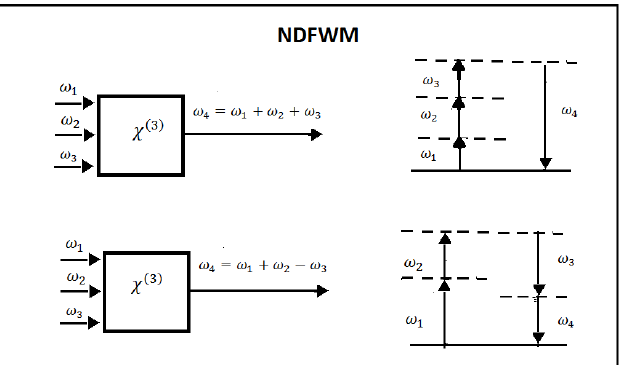
Figure 3. Non-degenerate four-wave mixing. Two of the possible mixing process that can occur when three input waves interact in a medium. On the left are the geometries of the interactions, and on the right are the energy level diagrams describing the interactions.